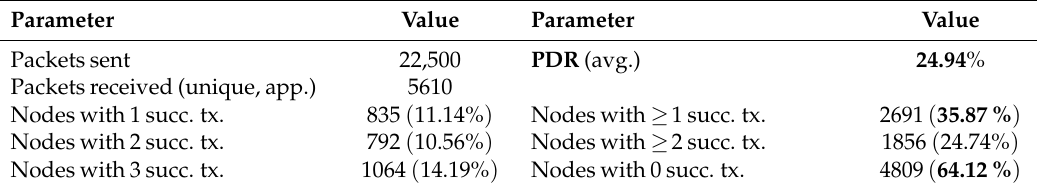
Table 2. Baseline scenario results